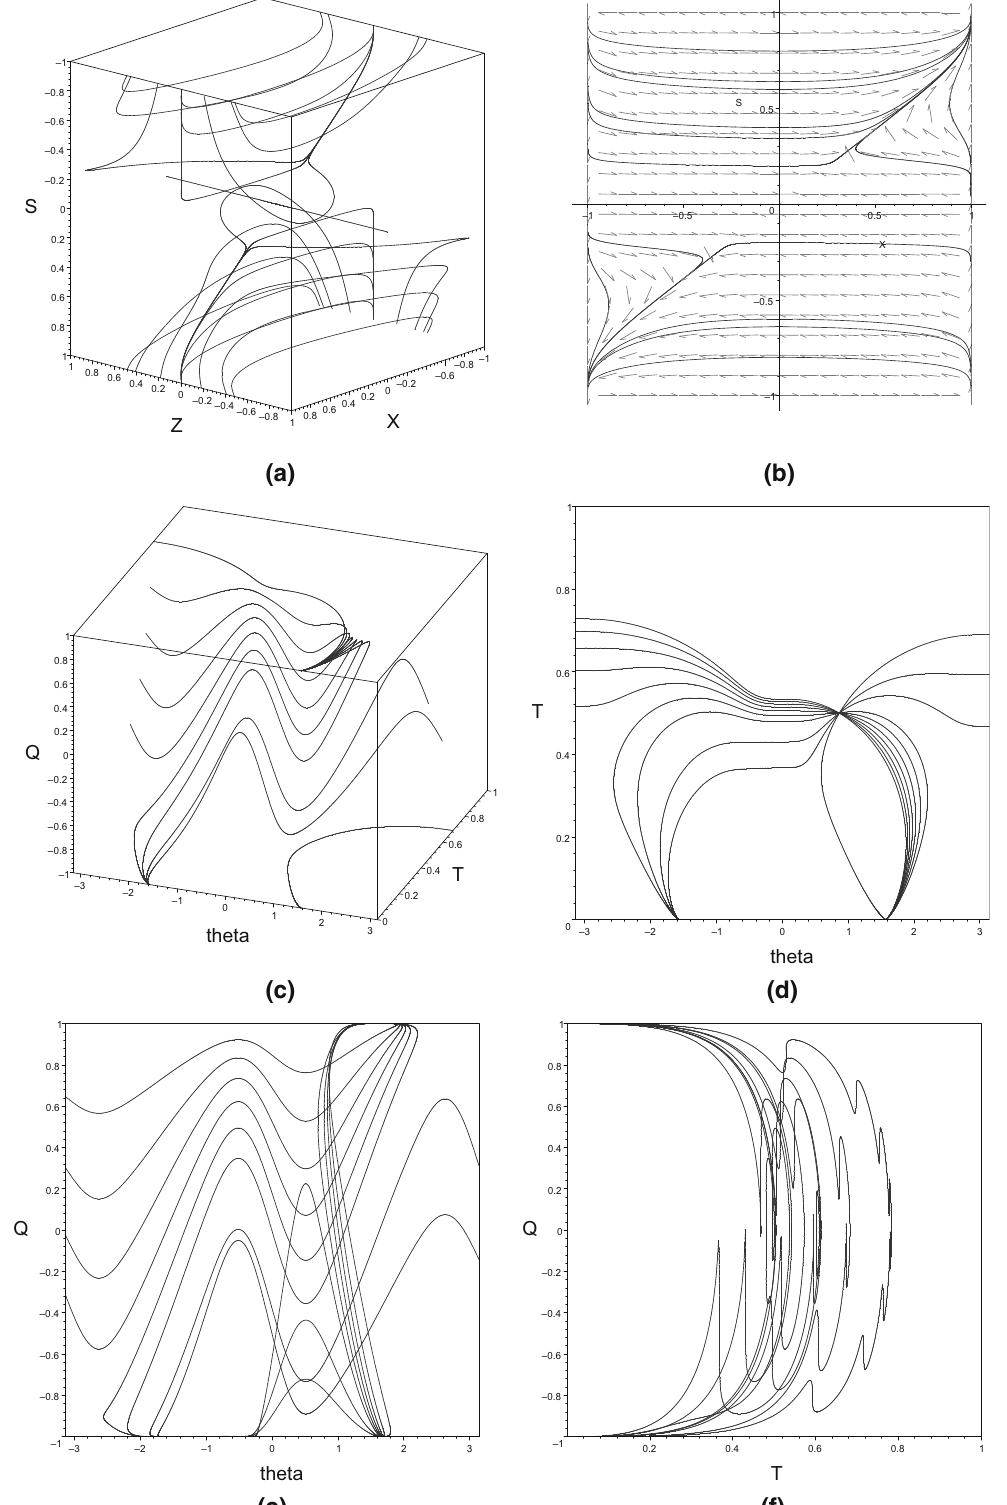
Fig. 5 a Compact phase portrait of (123), (124), (125) for the choice n = 2. b Dynamics in the invariant set Z = 0. c – f Dynamics of the system (150), (151), (152) and some 2D projections for the choice n =